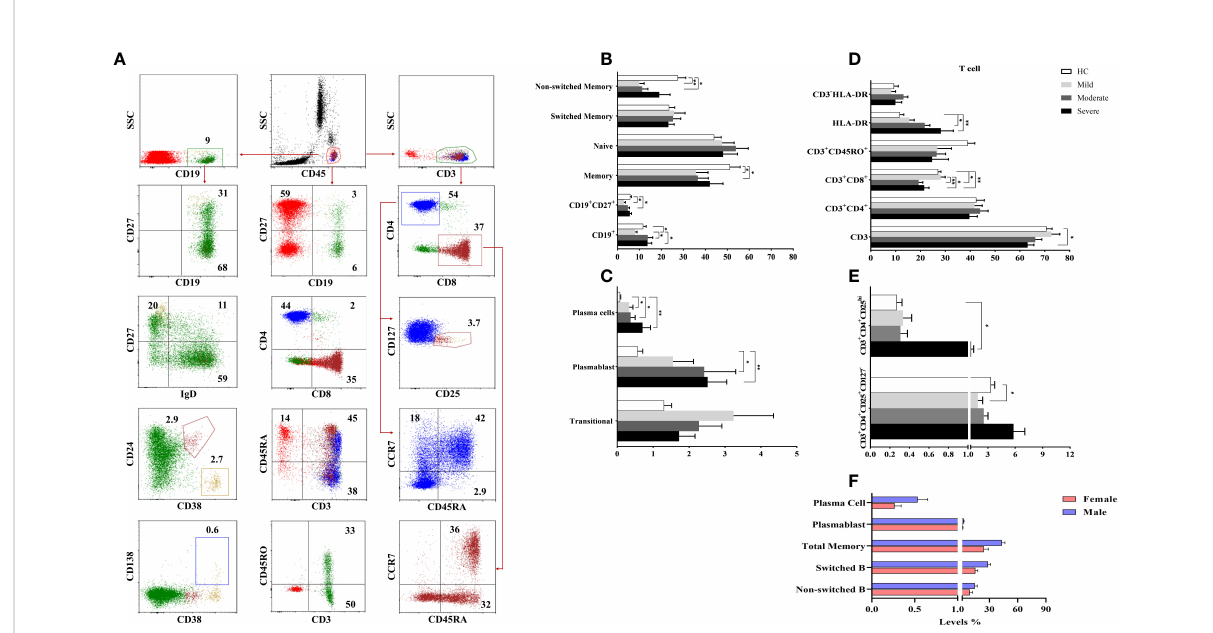
FIGURE 3 The frequencies of B and T cell subsets. (A) The gating strategy of T and B cell subsets were shown in the representative fi gure. (B, C) The frequencies of B and (D, E) T cell subsets were shown in patient groups and healthy controls. (F) The differences of B cell subsets between male and female patients with COVID-19. *p<0.05, **p<0.001, HC, Healthy